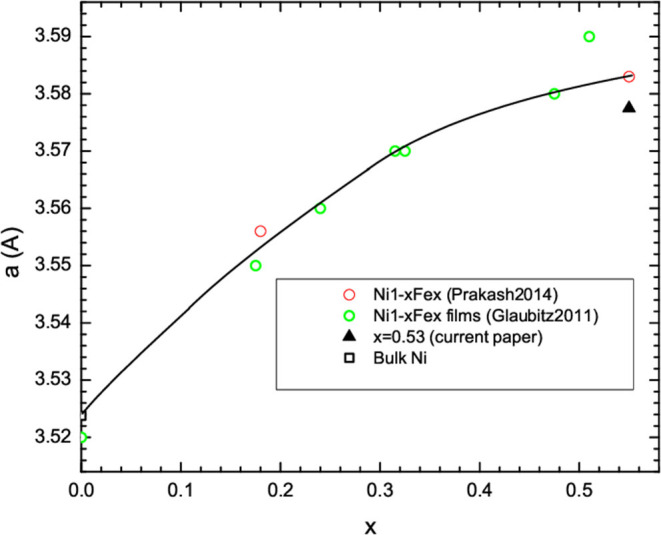
Fitting of XRD data for lattice parameter comparison with previous literature.